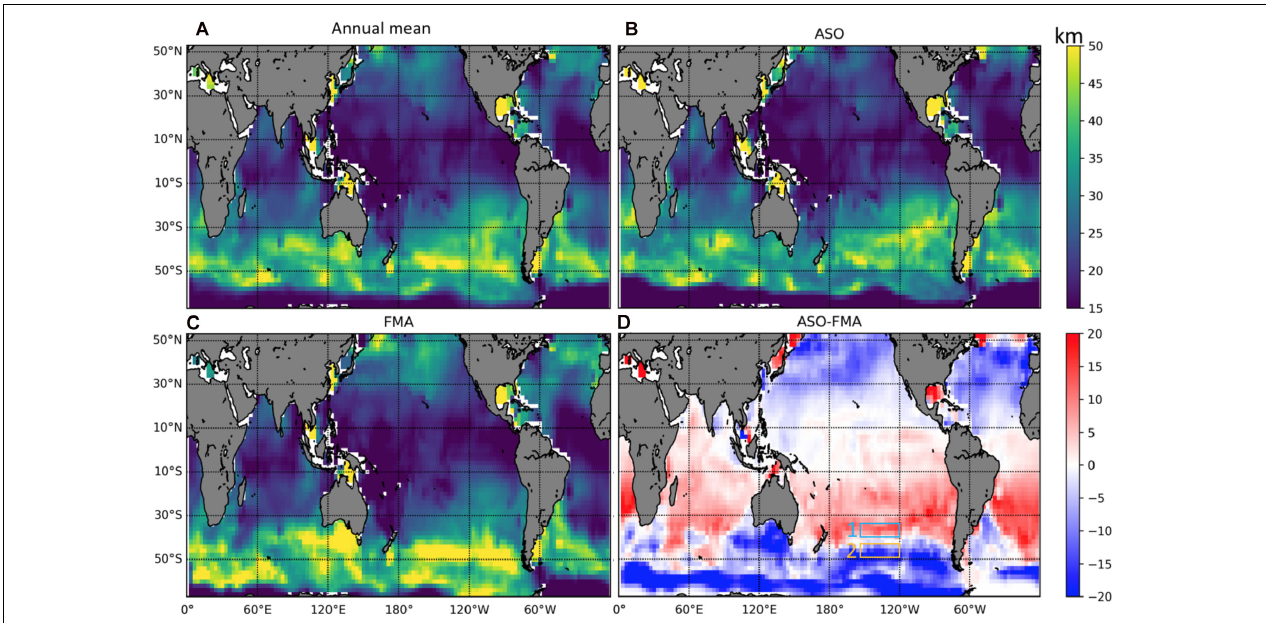
FIGURE 4 | SWOT effective spatial resolution (signal above noise) estimated from a model and simulated noise (A) averaged annually, (B) in August–September–October (ASO), (C) in February–March–April (FMA). The seasonal change (ASO-FMA) is shown in (D) (after Wang et al., 2019; copyright 2019 , American Meteorological Society